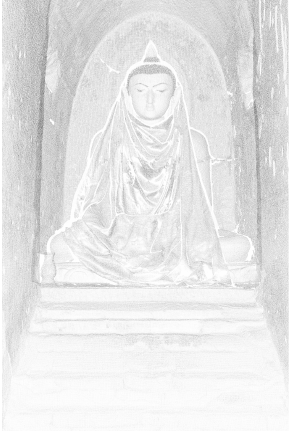
Figure 3. Myin-pya-gu interior detail Point Cloud.